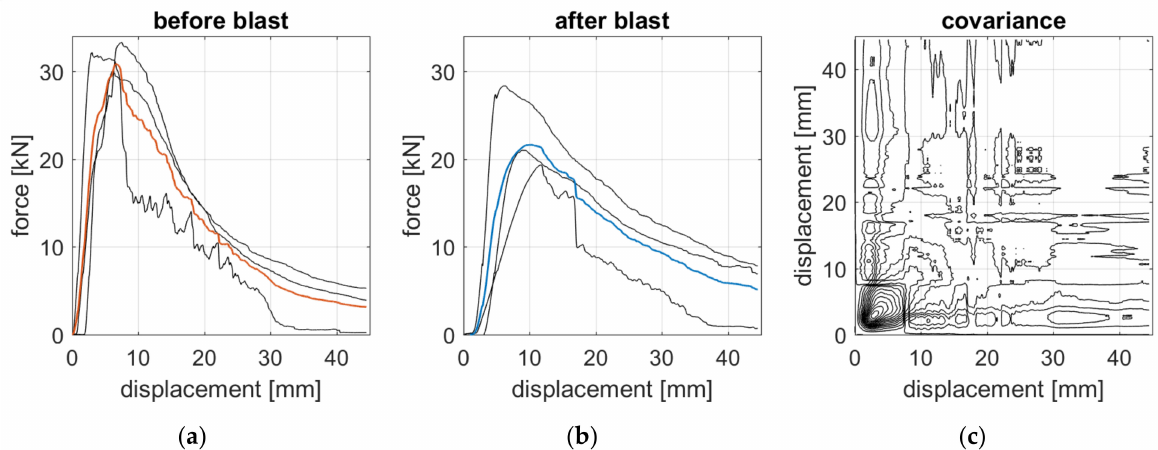
Figure 23. Individual curves together with their mean function and common covariance function: ( a ) Mean function of specimens before blast loading; ( b ) Mean function of specimens after blast loading; ( c ) Contour plot of common covariance function of the two